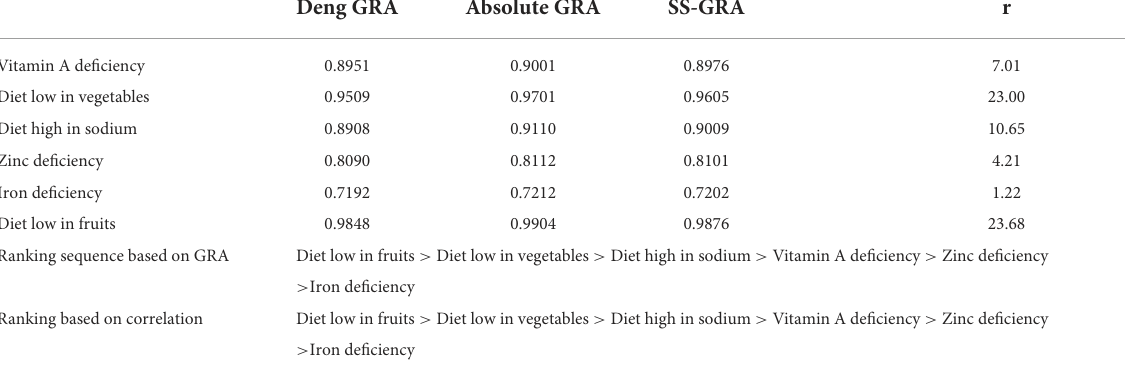
TABLE 2 Grey relational assessment for stroke morbidity with nutritional risk